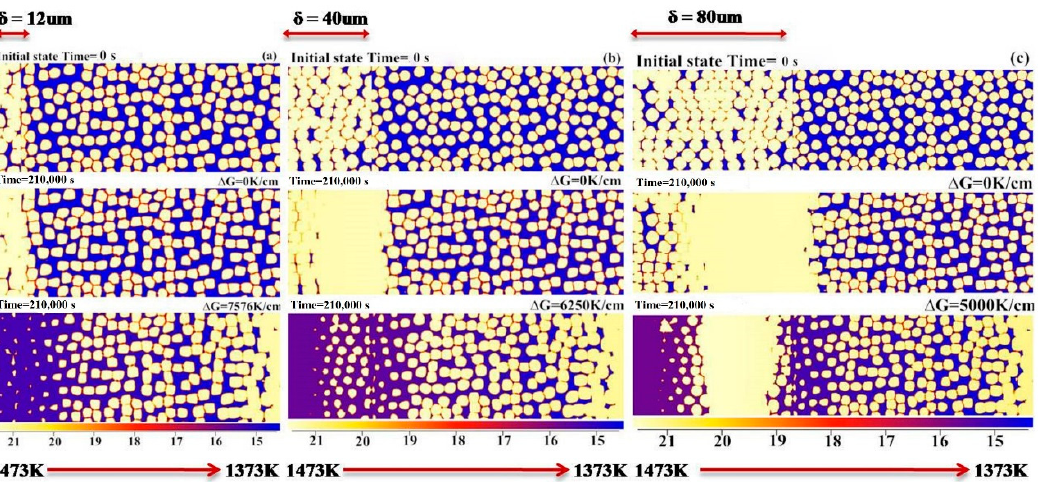
Figure 14. Interdiffusion microstructure evolution of No. 9 bond coat/substrate system (Ni–20at.%Al–4at.%Cr/Ni–18at.%Al–12at.%Cr) with different bond coat thicknesses at constant temperature (1373 K) and with an effect of temperature gradient ( ∆ G = 5000 K/cm): ( a ) 12 µ m, ( b ) 40 µ m, and ( c ) 80 µ m. The color bar scale indicates the mole fraction of Al in atom percent.